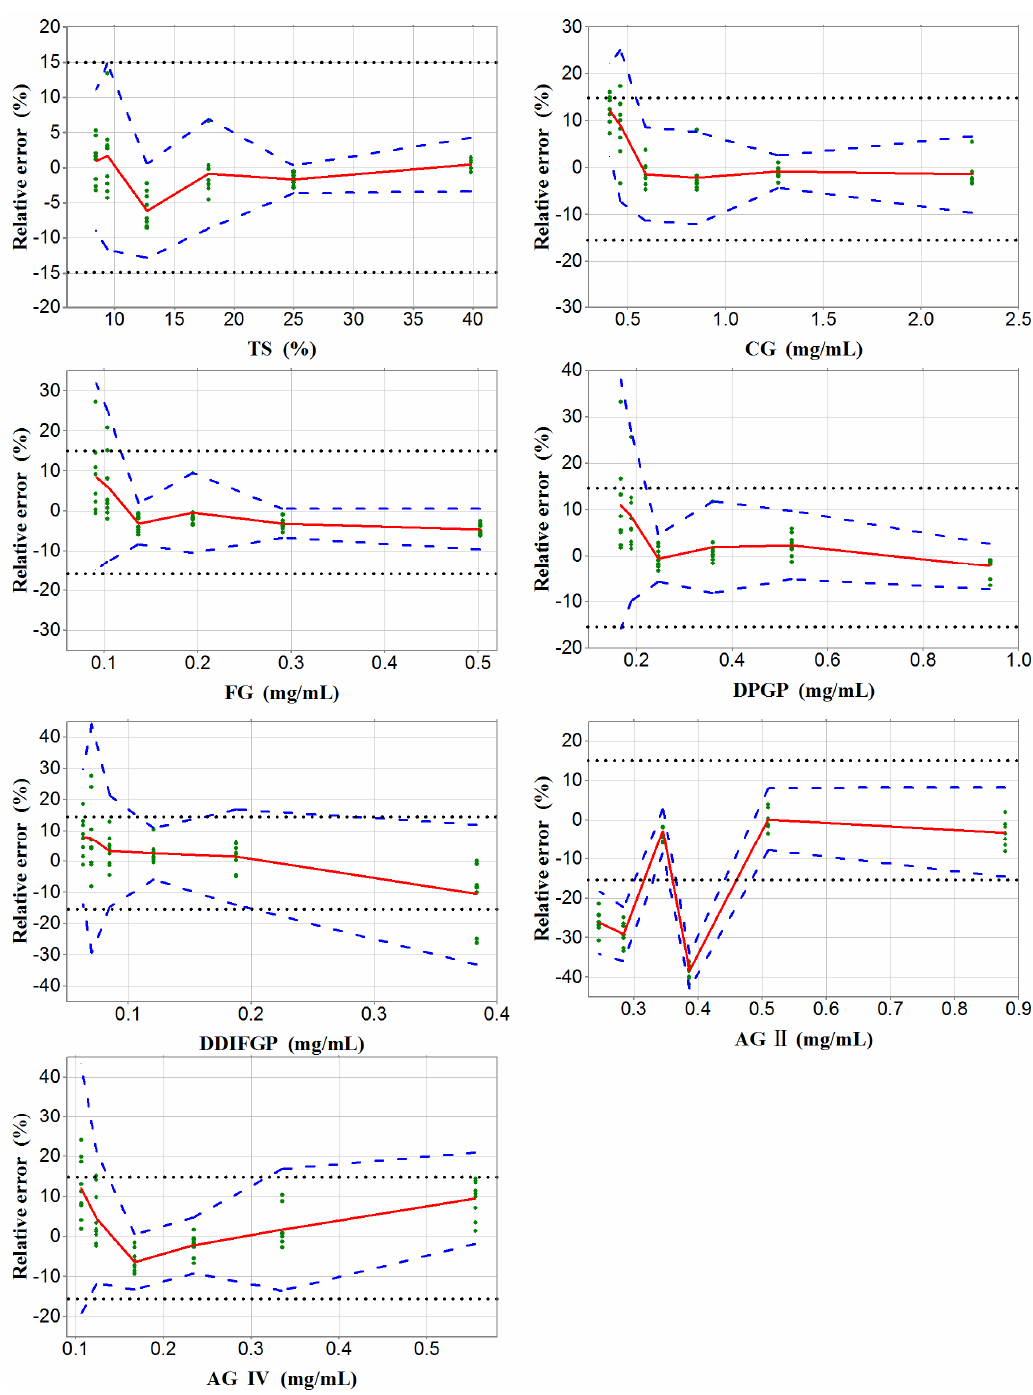
Figure 6. Accuracy profiles for the 7 PLSR models. (The plain red line represents the relative bias, the dashed blue lines represent the β -expectations tolerance limits ( β = 95%), and the dotted black lines represent the acceptance limits (±15%)).